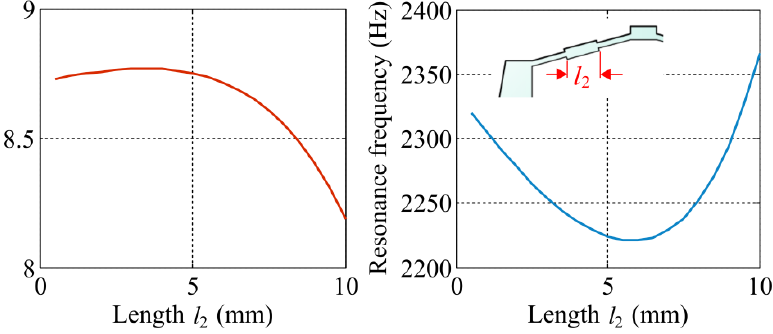
Figure 11. Theoretical results of the displacement amplification ratio and the main resonance fre- quency for the displacement amplification mechanism versus the length of internal links of the semi bridge-type amplifier.